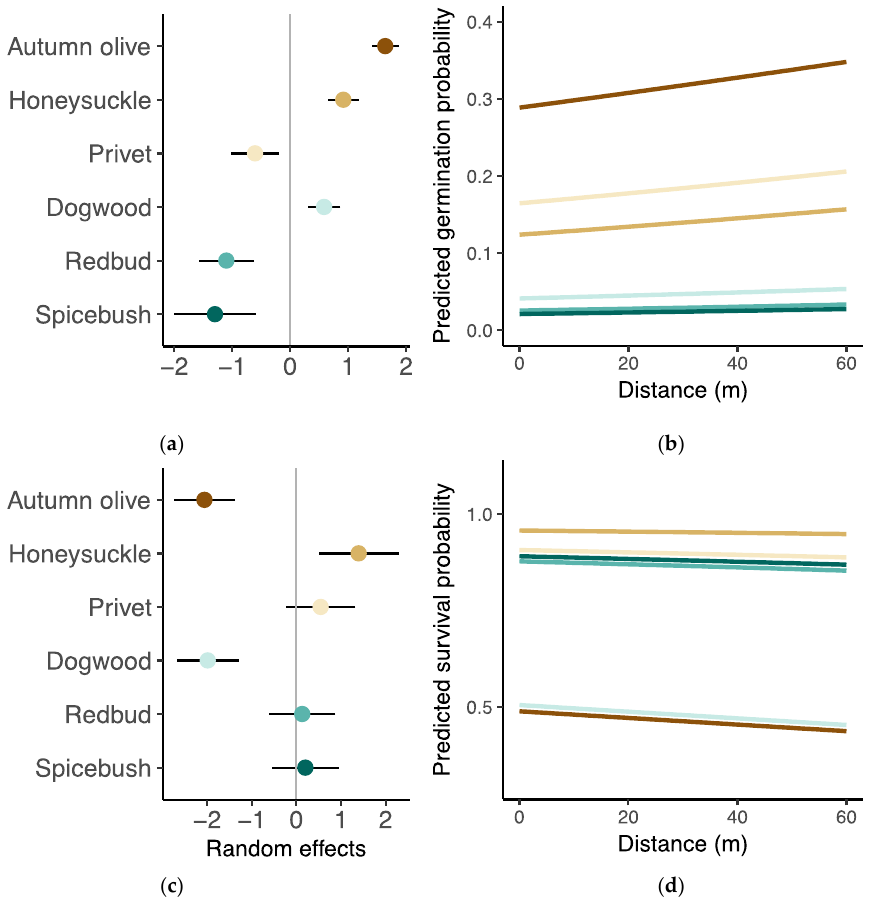
Figure 4. Graphical results from mixed effects models of survival and germination. ( a , c ) Differences between species intercepts ±95% confidence intervals and overall model intercepts and ( b , d ) the marginal effect of distance on germination and survival for each species. The brown shading indicates the group of invasive species while the blue shading indicates the group of native species.